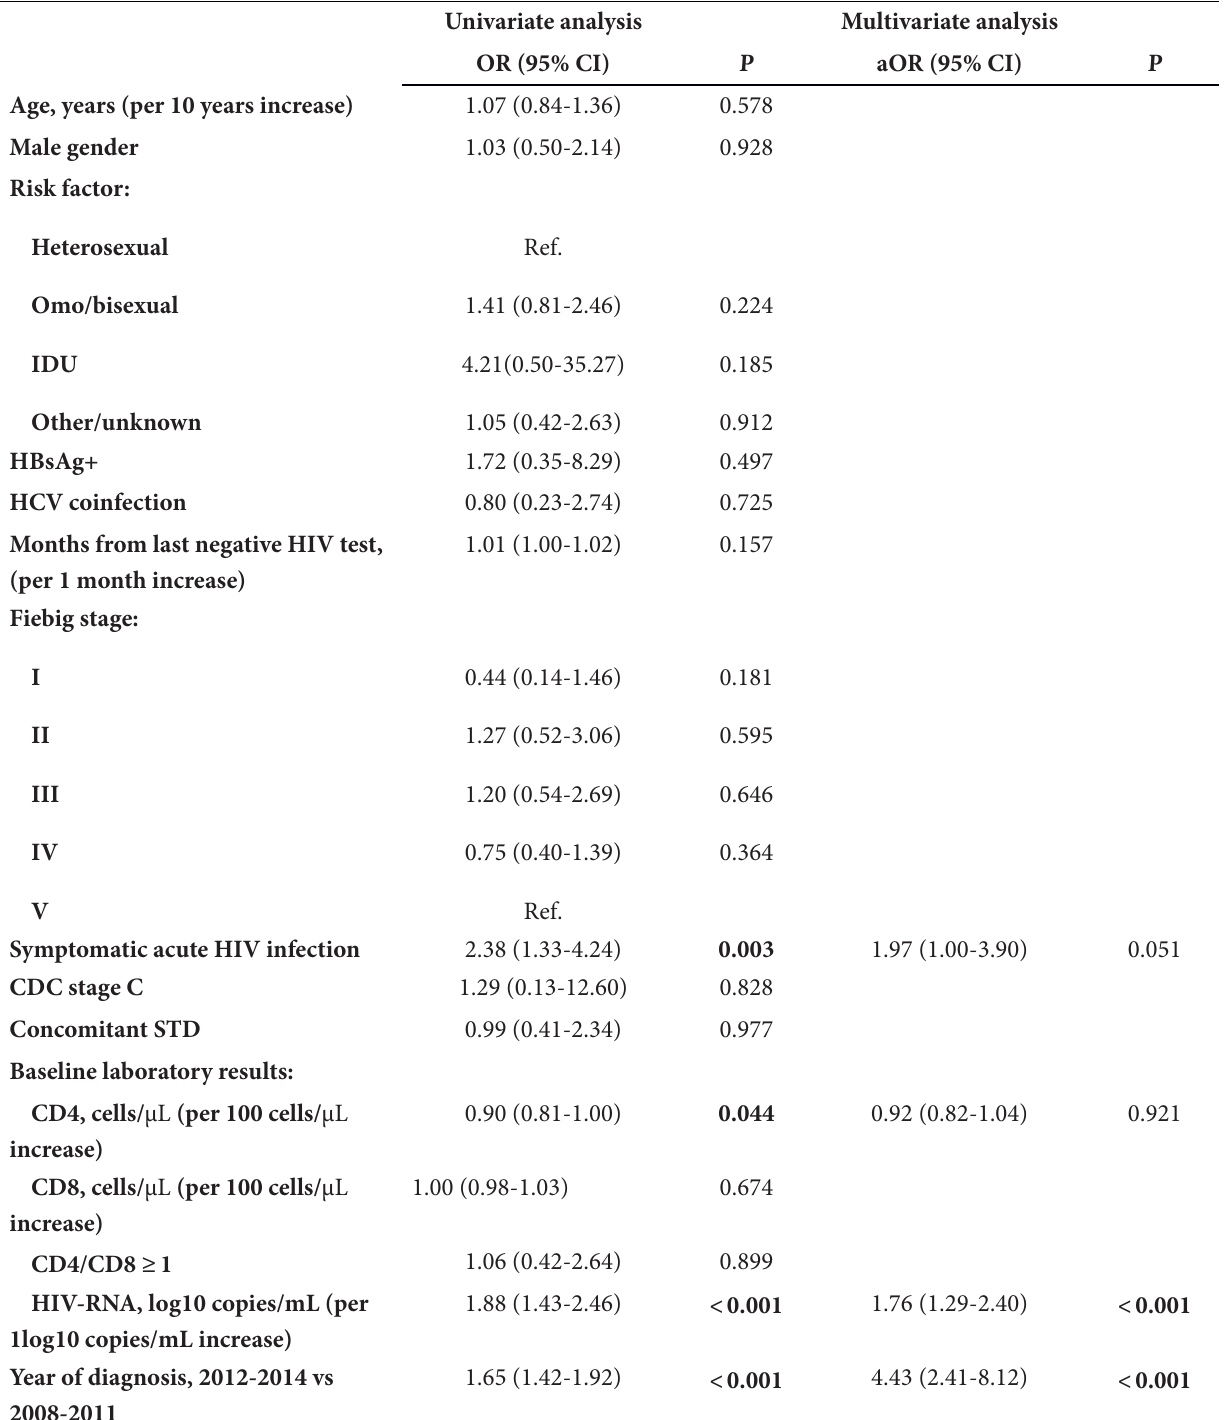
Table 2. Factors associated with early ART initiation (logistic regression analysis) Univariate analysis Multivariate